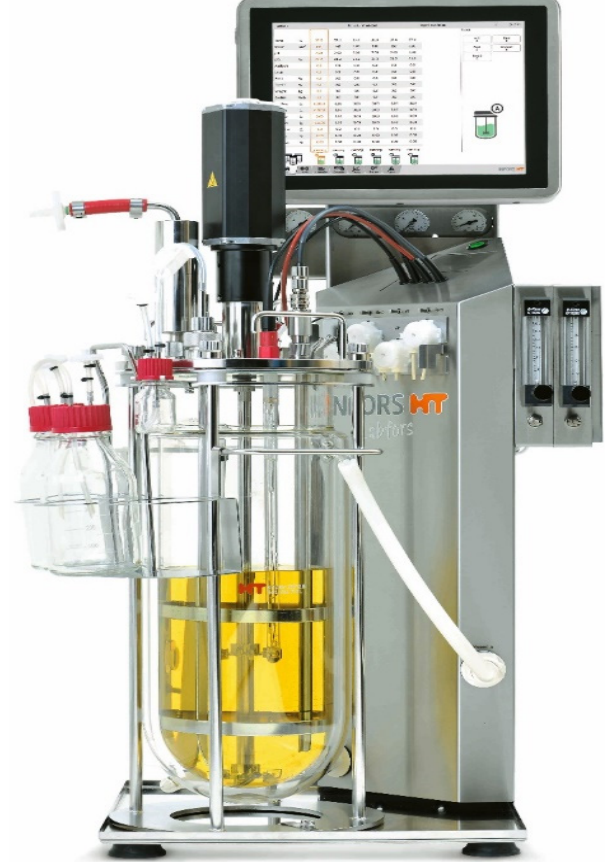
Figure 1. Bioreactor Labfors 5.